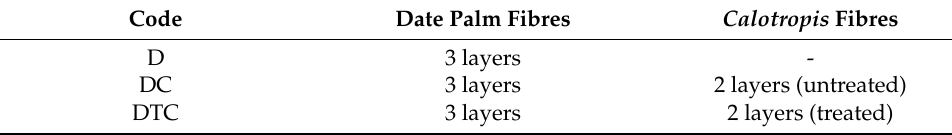
Table 1. The structure of experimental